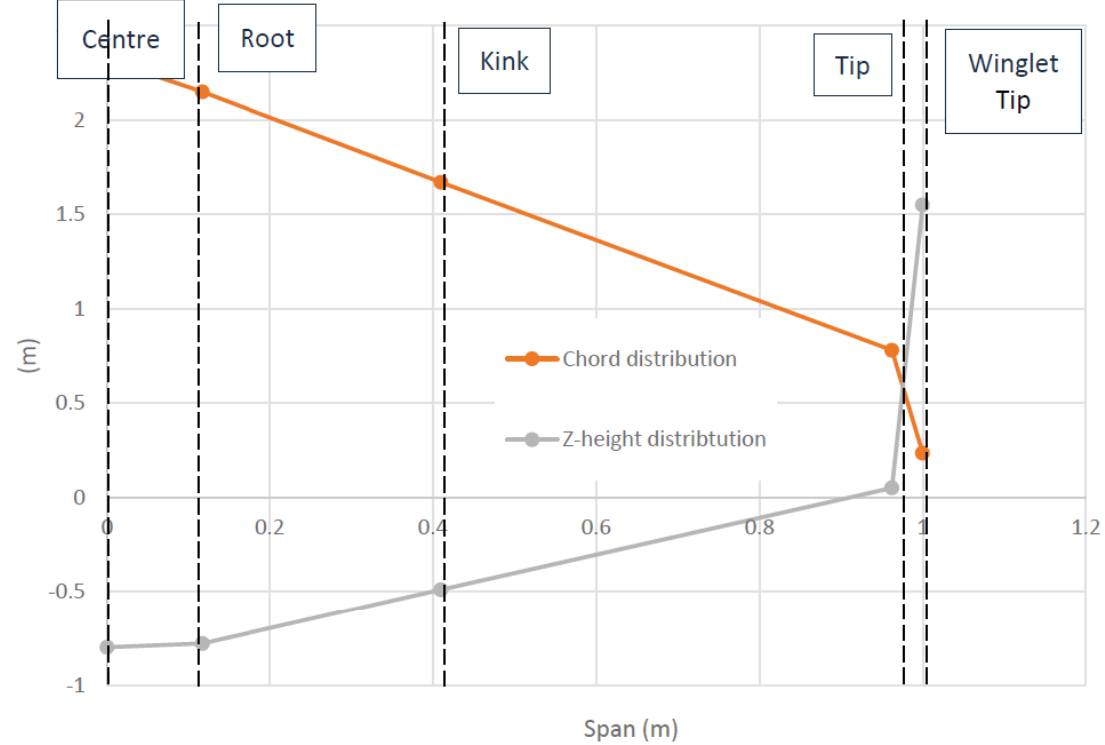
Figure 5. Reference model top view.